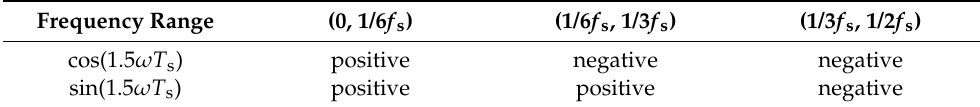
Table 1. Effect of digital delay in different frequency